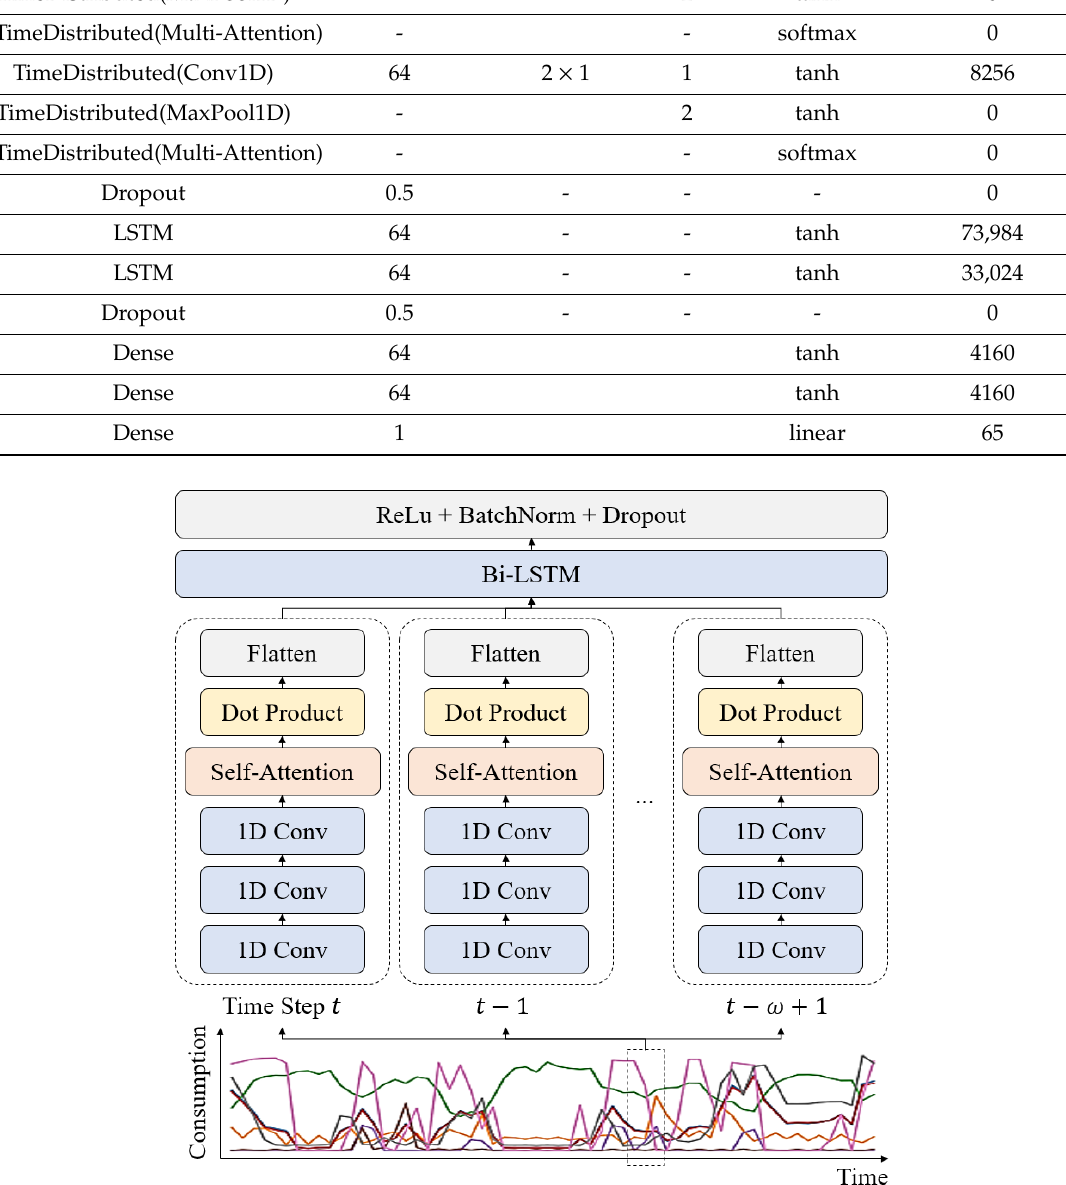
Figure 5. Implementation of the proposed CNN-LSTM with multi-headed attention.